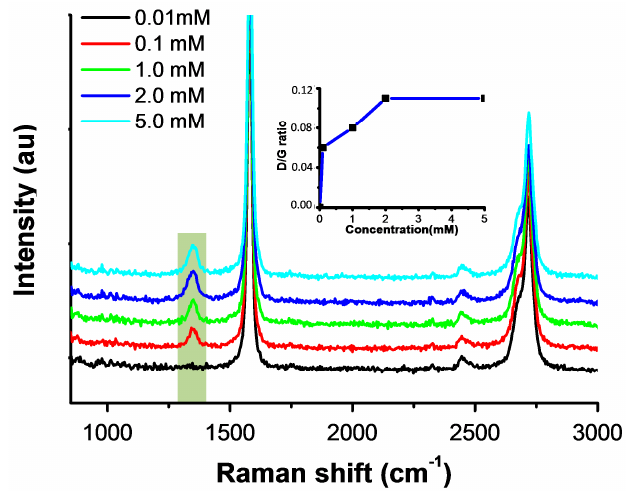
Figure 3. Raman spectra of pristine HOPG and 3,5-TFD-grafted HOPG showing an evolution of the D band peak with respect to the increased concentrations. The spectra were averaged over 5 sample spots. Integration time: 100